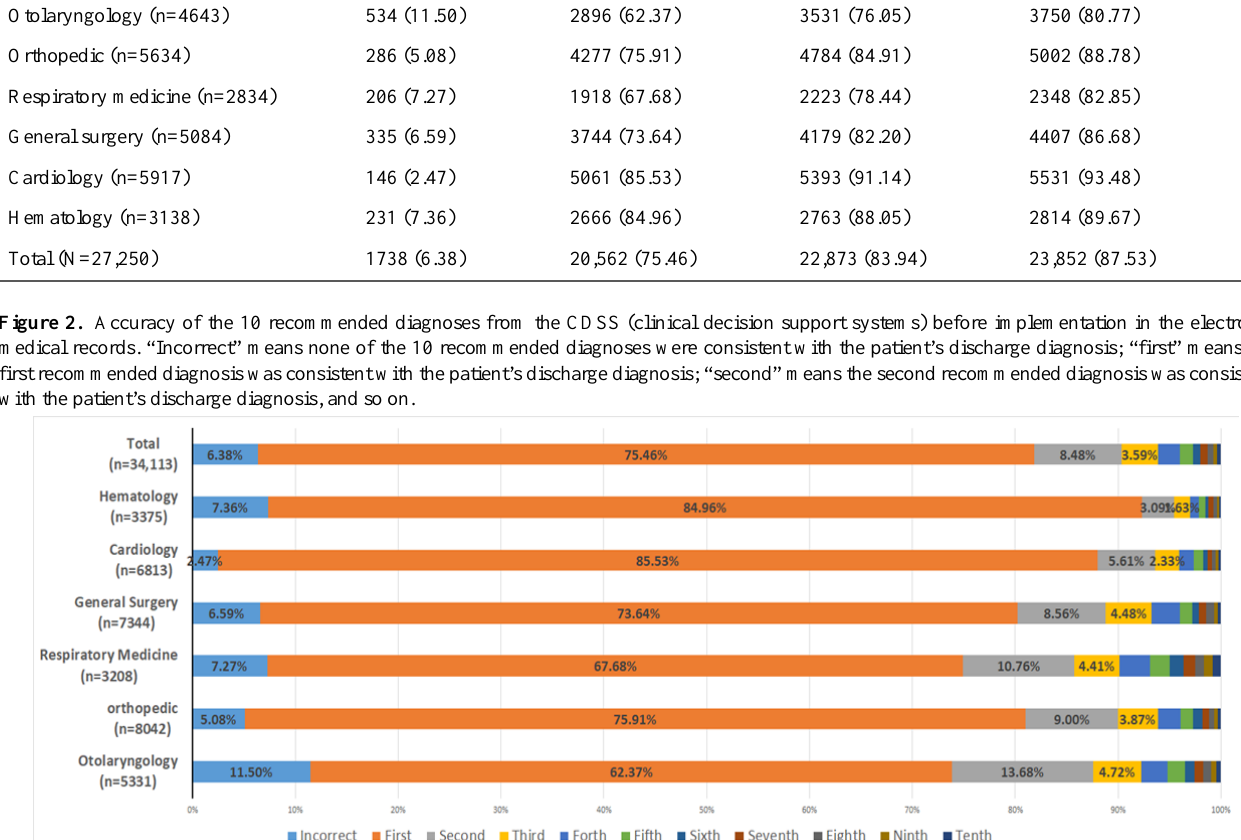
First three, n (%)First two, n (%)First, n (%)Incorrect, n (%)Department